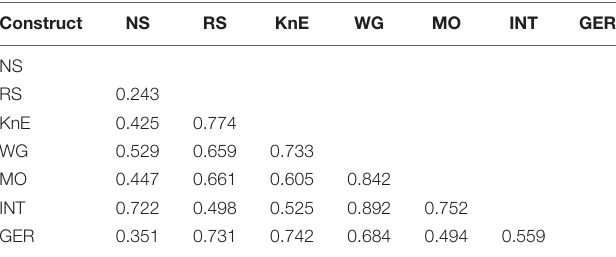
TABLE 4 | Hetero trait-mono trait scores.